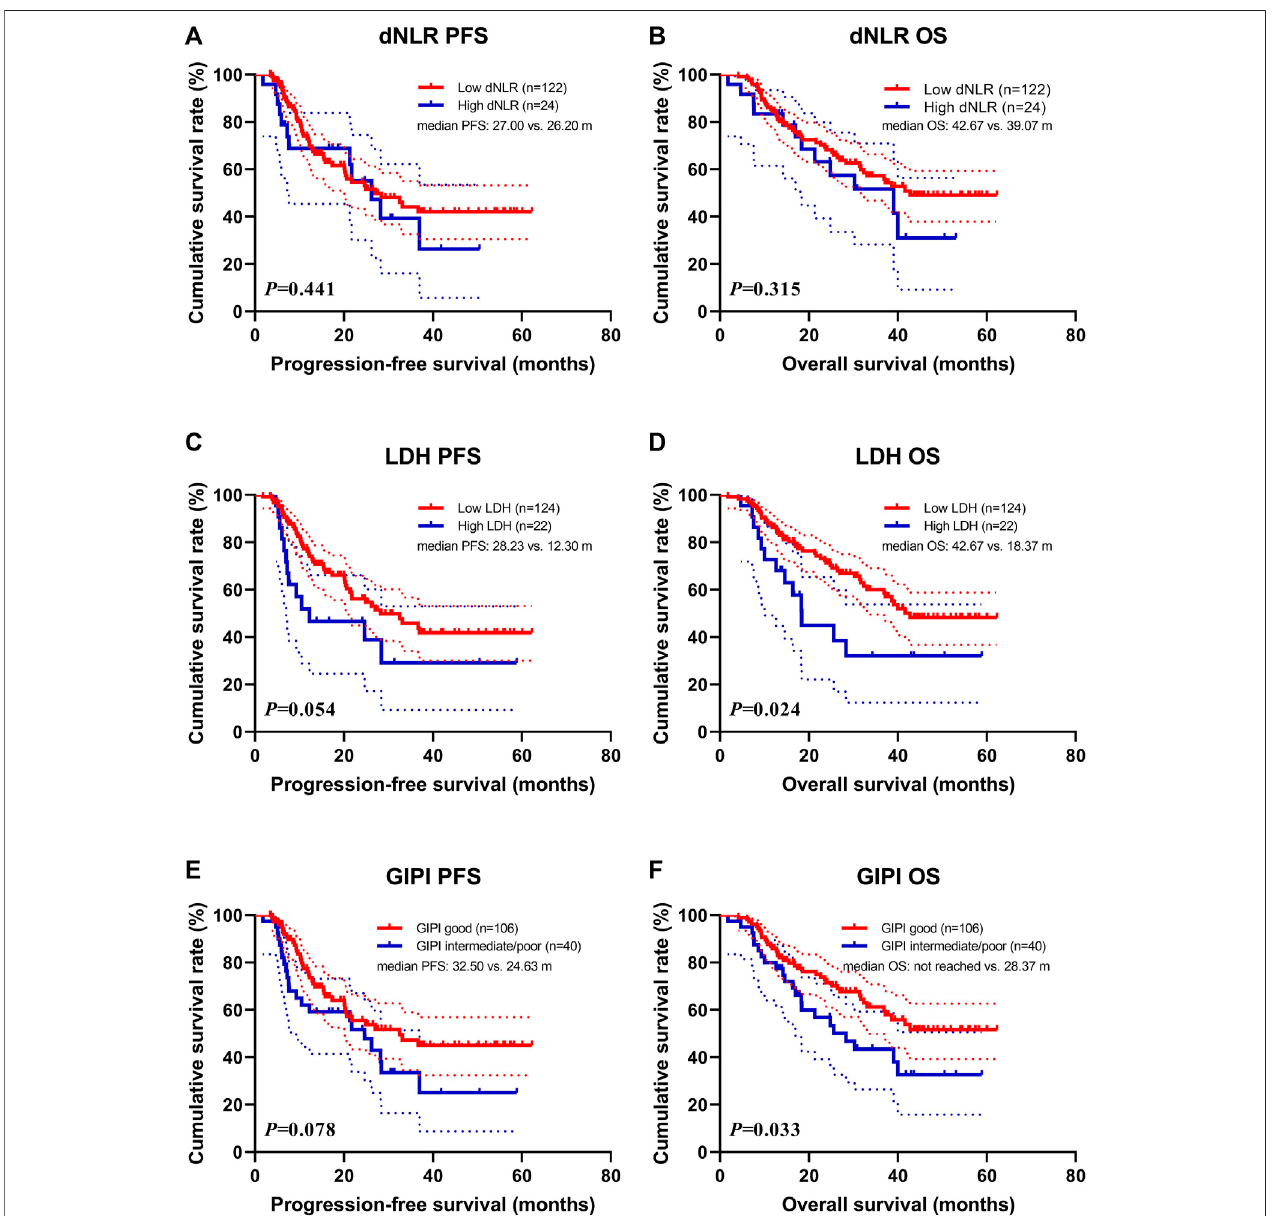
FIGURE1| Survivalaccording todNLR, LDH,and GIPI groupsfor (A) progression-free survival(PFS) bydNLR; (B) overallsurvival (OS)bydNLR; (C) PFS byLDH; (D) OS by LDH; (E) PFS by GIPI; (F) OS by GIPI.